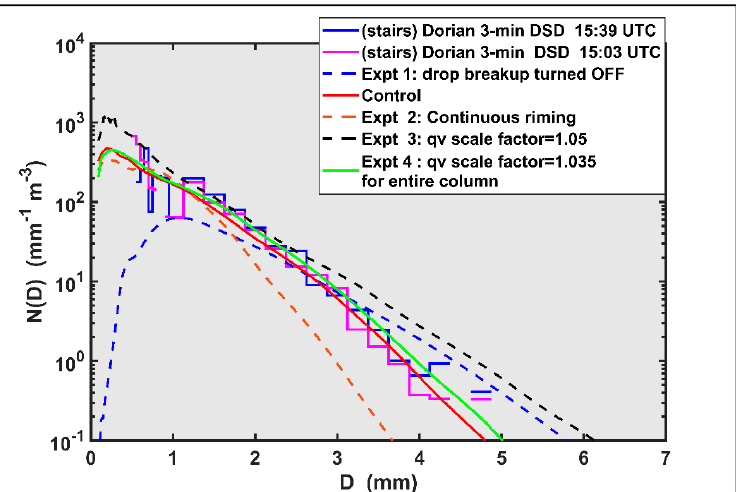
Figure 7. Drop size distributions from disdrometers averaged over 3 min shown as stairs plot. The continuous solid and dashed lines are from the control run and experiments 1–4 as indicated in the legend (see, also, Table 1). Atmosphere 2020 , 11 , x FOR PEER REVIEW